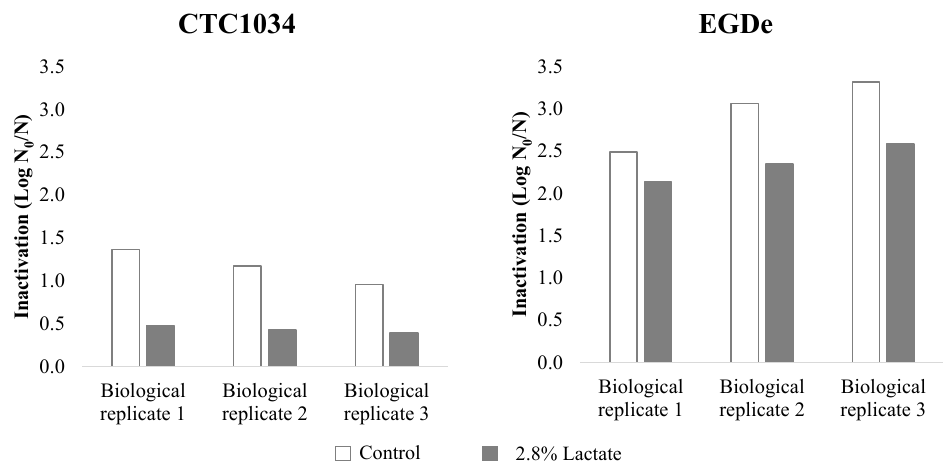
Figure 1. Inactivation (Log N 0 /N) of each biological replicate of the L. monocytogenes CTC1034 and EGDe strains observed after HPP (400 MPa for 10 min) in cooked ham model medium without (control) and with 2.8% ( v/v ) potassium lactate.